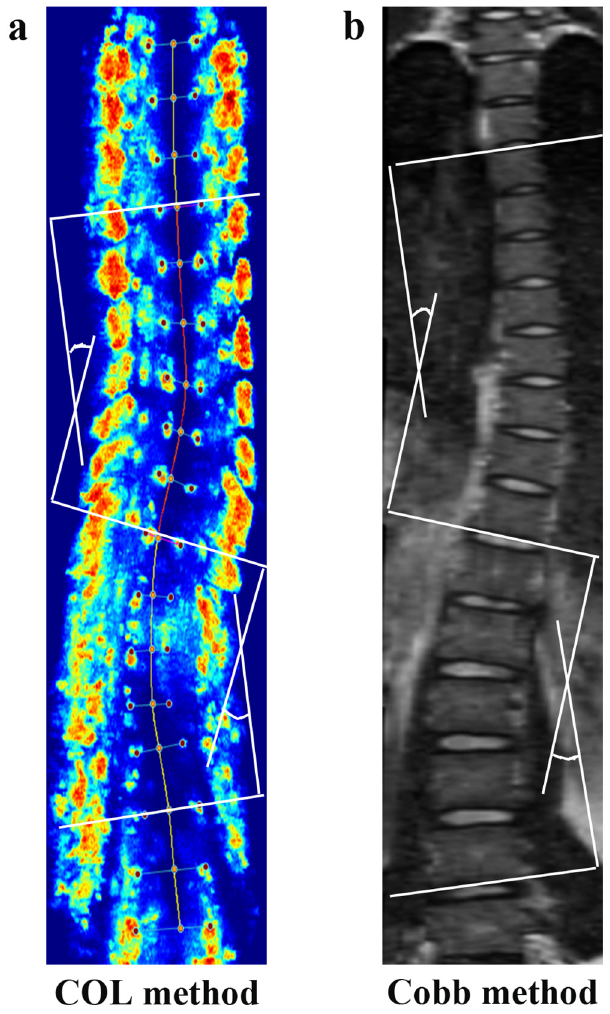
Fig 3. Spinal curvature measurement using. (a) Center of laminae (COL) method in ultrasound; (b) Cobb method in MRI.